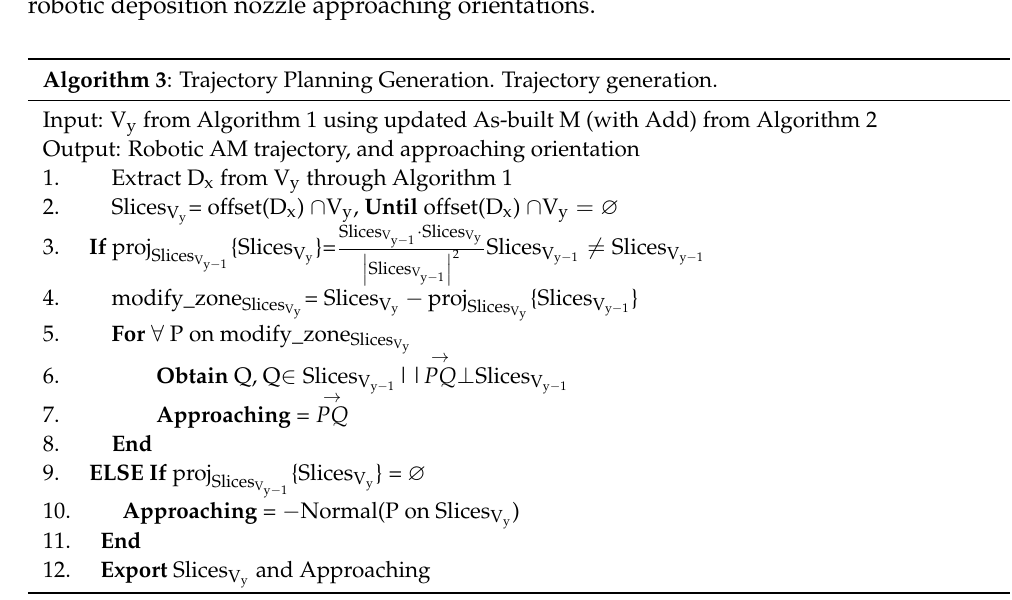
Algorithm 3: Trajectory generation.